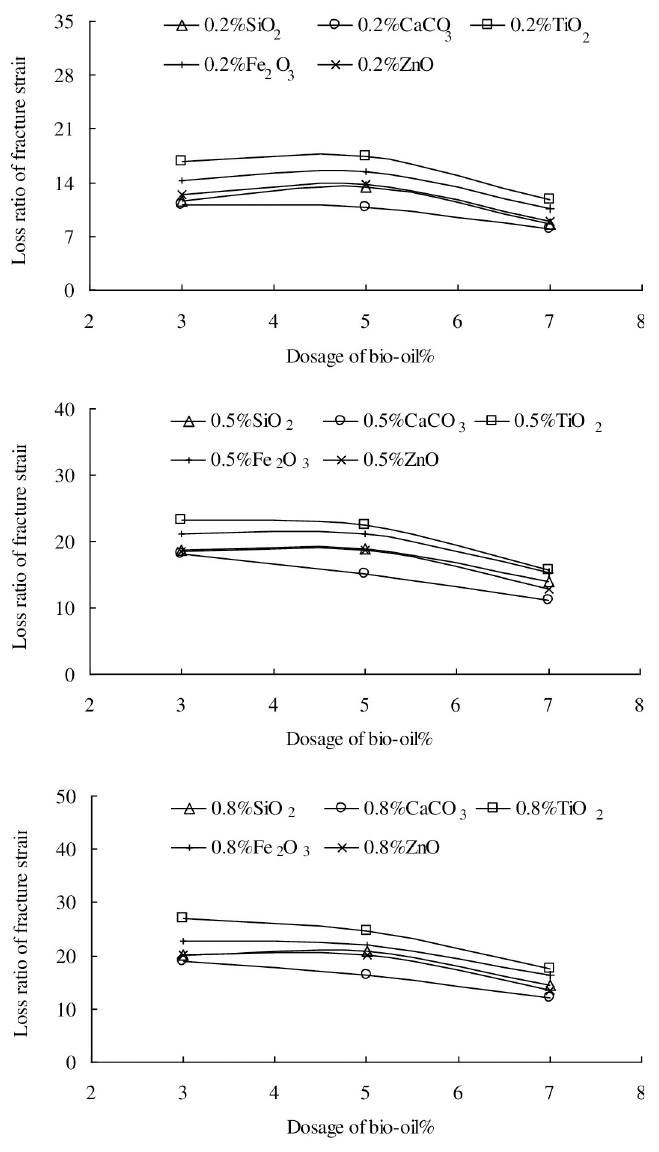
Fig 7. Loss ratio of fracture strain.